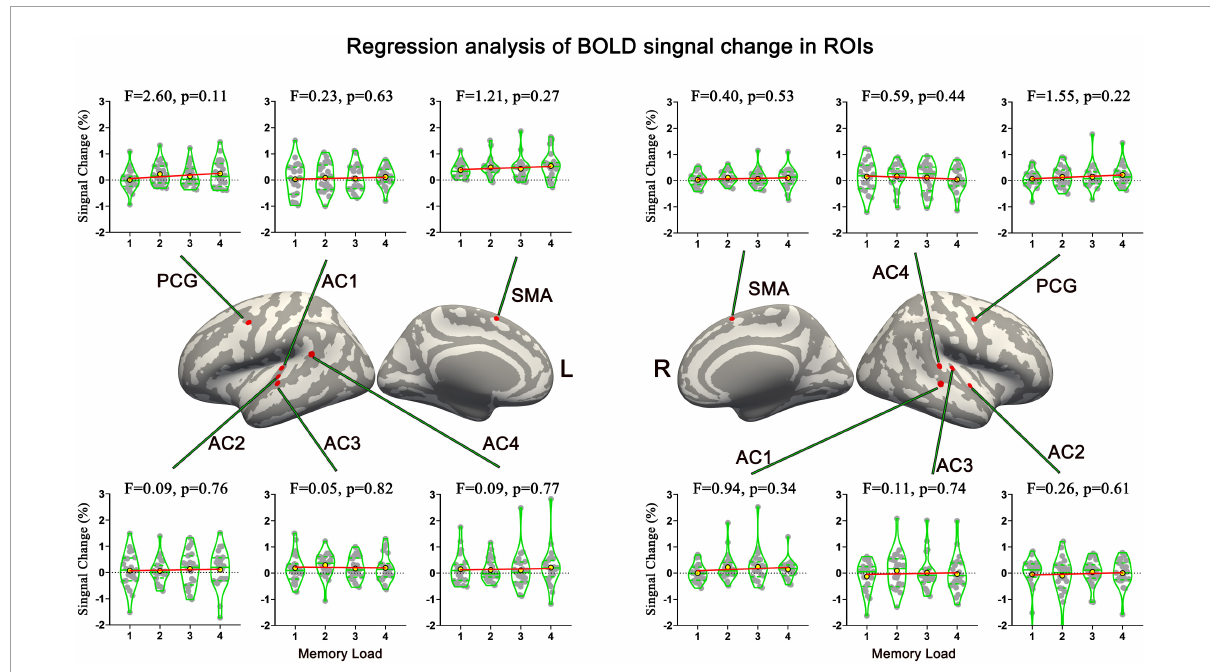
FIGURE6 Names and locations and regression analysis results of neural response strength of 12 ROIs. No brain area’s response strength was linearly correlated with memory load. AC, auditory cortex; PCG, precentral gyrus; SMA, supplementary motor